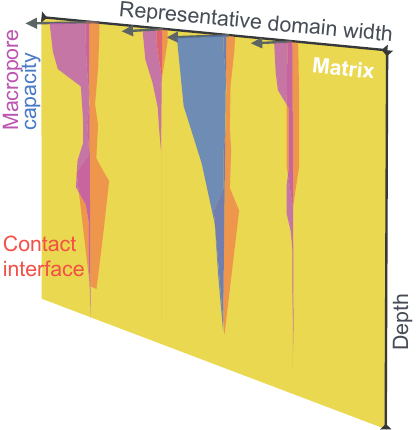
Figure 1. Representative macropore–matrix domain. A 2-D soil matrix with a periodic lateral boundary hosts several 1-D macro- pores with their respective capacities, interfaces and lateral distri- butions.